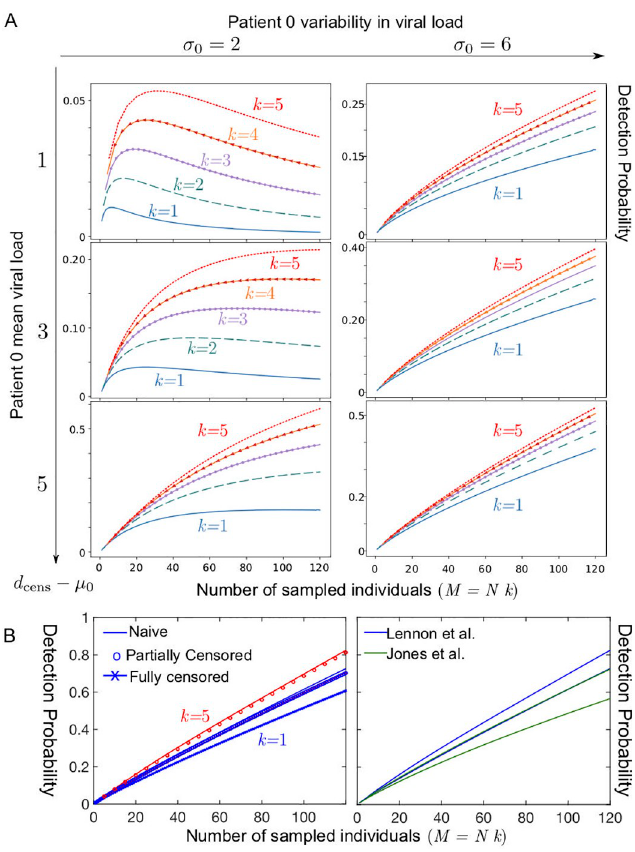
Fig 5. Detection probability within a community of 120 as a function of the total number of sampled individuals M = k × N , where k is the total number of tests used and N the number of samples pooled together in a test (A) Case of a single patient 0 with low viral load; k = 5 (red dotted line); k = 4 (orange line with arrow), k = 3 (purple line with circles); k = 2 (dashed green line); k = 1 (solid blue line) for several values in the parameters describing the viral load of the patient 0 at the onset of contagiosity, expressed in terms of a normal distribution in C (the number of RT-qPCR t amplification cycles) with a standard deviation σ 0 and a mean μ 0 and a threshold at a value denoted d cens satisfying: μ 0 = d cens − 1 (top row), modelling a patient 0 with a very low viral concentration, μ 0 = d cens − 3 (middle row), μ 0 = d cens − 5 (bottom row); σ 0 = 2 (left column); σ 0 = 6 (right column). (B) Case of a single patient 0 with a viral load distributed datasets(left) for the three fitting methods used to describe the asymptomatic dataset corresponding to Lennon et al. [55], for k = 1 (blue) and k = 5 (red)and (right) comparing the datasets of Lennon et al. [55] and Jones et al. [56] for the naive fitting method (upper curve k = 5, lower curve k =